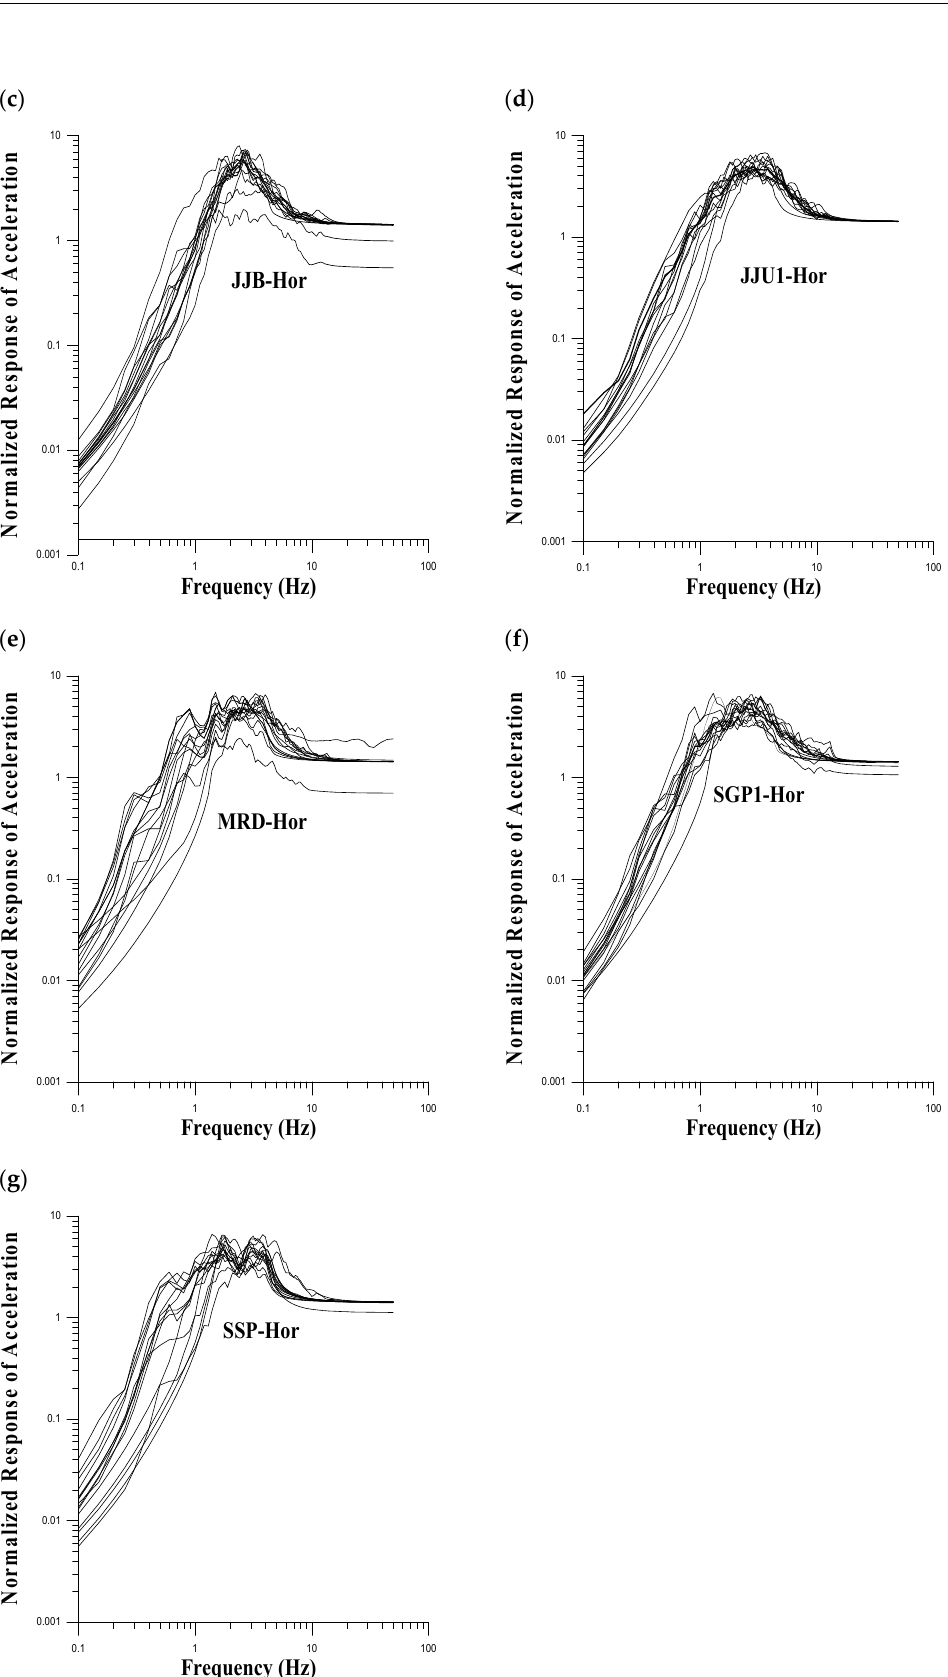
Figure 4. Normalized horizontal response spectra at ( a ) GOS, ( b ) HALB, ( c ) JJB, ( d ) JJU1, ( e ) MRD, ( f ) SGP1, and ( g ) SSP using Kumamoto earthquakes